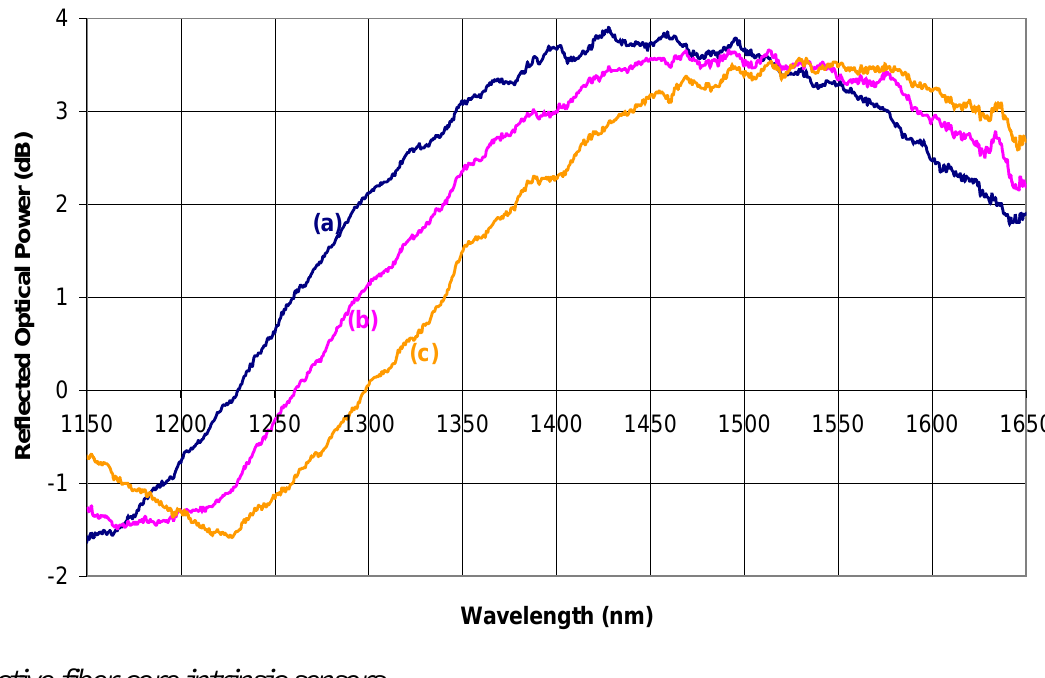
Figure 11 . Dichloromethane fiber optic sensor based on a micrograting located at the end of the fiber. Spectral response of the sensor to different concentrations of dichloromethane in (a) purged air; (b) 7.18 mmol/L and (c) 19.44 mmol/L (saturated atmosphere). Notice that there is no variation at 1520 nm and this wavelength can be used as a reference signal